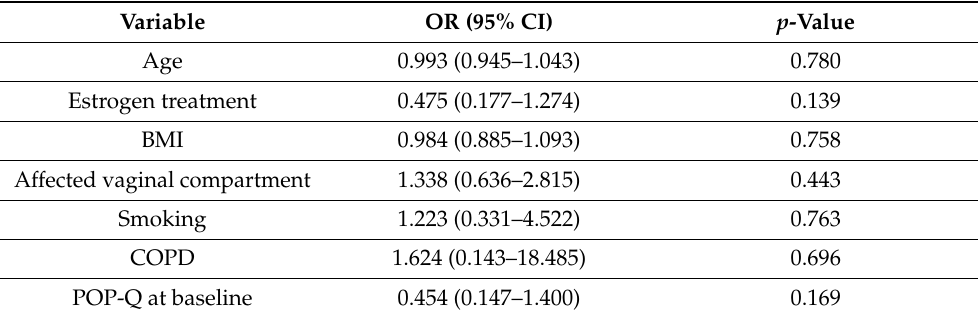
Table 3. Multiple logistic regression analysis to identify independent risk factors for complications with the covariates age, estrogen pre-treatment, BMI, affected compartment, smoking, COPD and POP-Q at